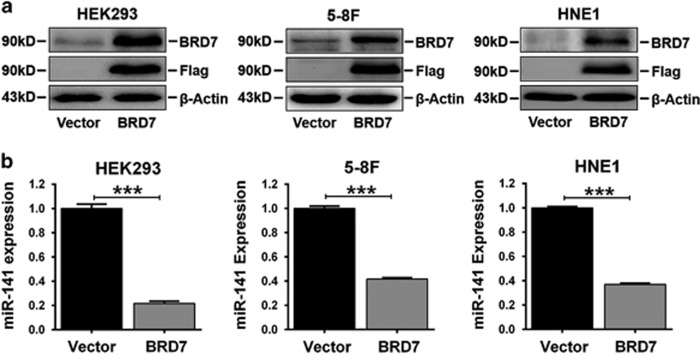
miR-141 was downregulated by BRD7 overexpression in HEK293, 5-8F and HNE1 stable cell lines. (a) Western blot using antibodies specific for BRD7 and Flag tag confirmed the exogenous BRD7 protein levels. β-Actin served as an internal control. (b) Mature miR-141 expression was detected by qRT-PCR. U6 served as an internal control. The error bars are represented as the mean±S.E.M. ***P<0.001. All experiments were performed in triplicate